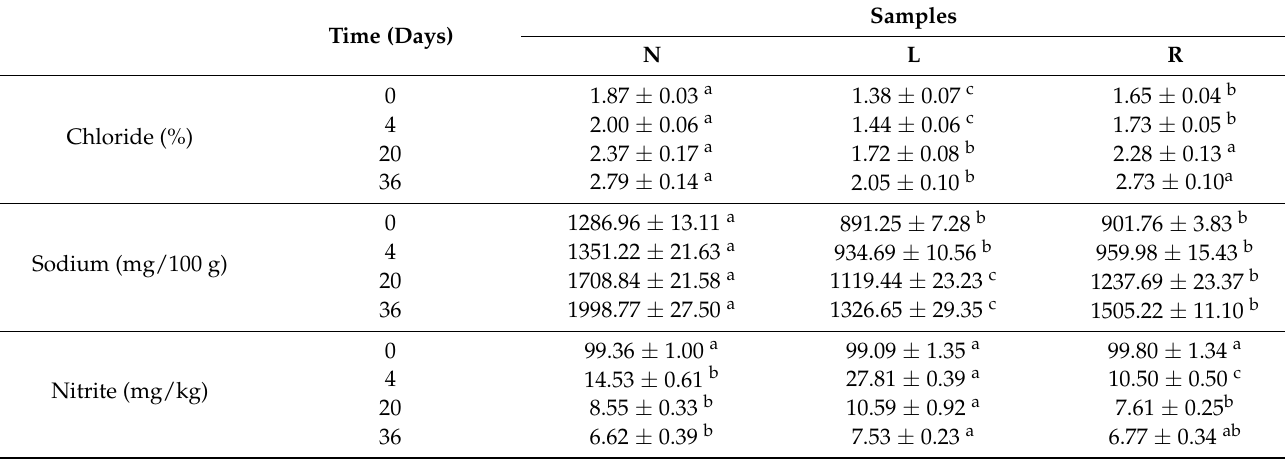
Table 1. Evaluation of chloride, sodium and nitrite contents of the fermented sausages. Samples Time (Days) N